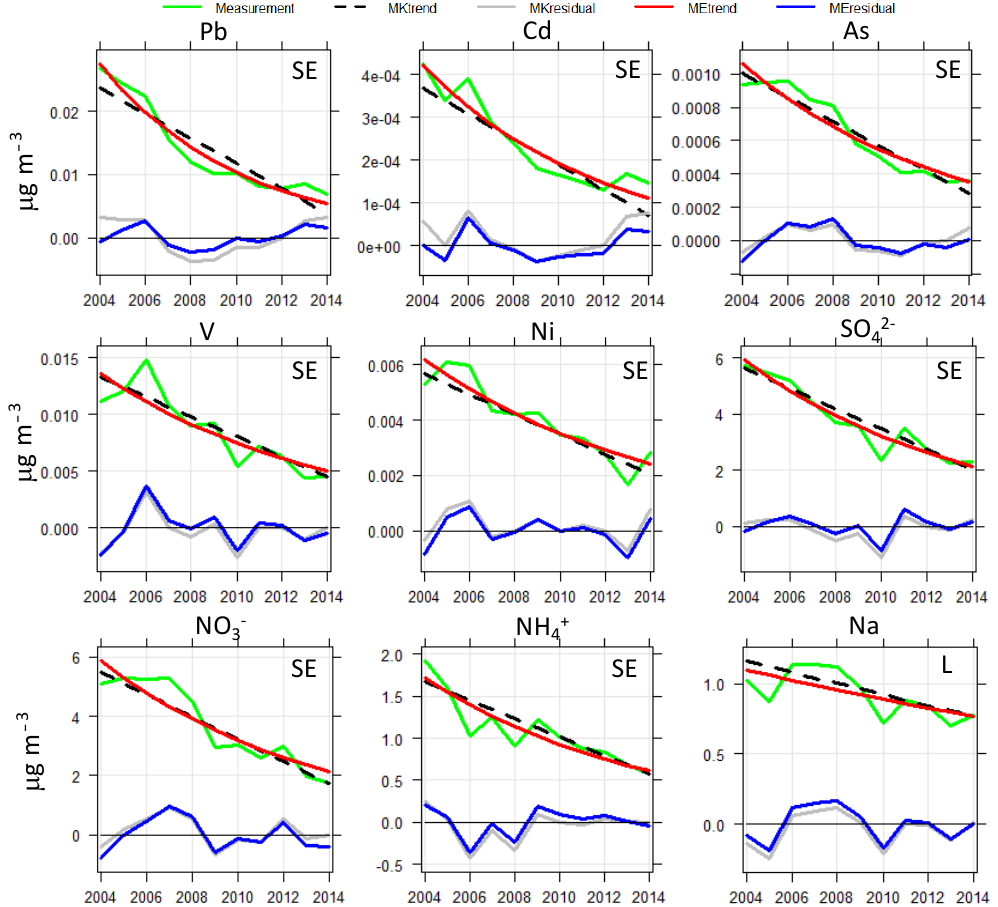
Figure 3. Mann–Kendall (MK) and multi-exponential (ME) trends for chemical species at BCN in PM 10 . Measured concentration (green line); multi-exponential trend (red line); multi-exponential residuals (blue line); Mann–Kendall trend (black line); Mann–Kendall residuals (gray line). Trend type: linear (L), single exponential (SE), double exponential (DE).